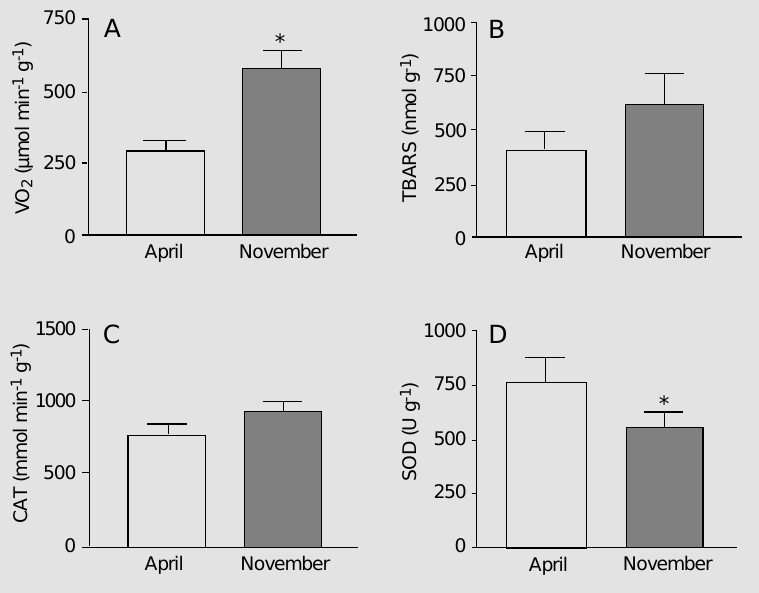
Figure 4. Seasonal pattern of different parameters measured in the liver of Geophagus brasiliensis. A , Oxygen consumption (VO 2 , µmol min -1 g -1 ); B , cellular damage (TBARS, nmol/g); C , catalase activities (CAT, mmol min -1 g -1 ); D , superoxide dismutase activities (SOD, U g -1 ). *P<0.05 compared to samples collected in April (Student t -test).